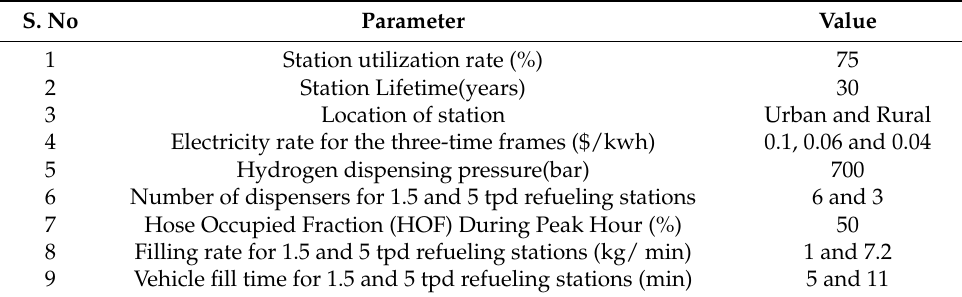
Table A5. Parameterization in HRSAM and HDRSAM